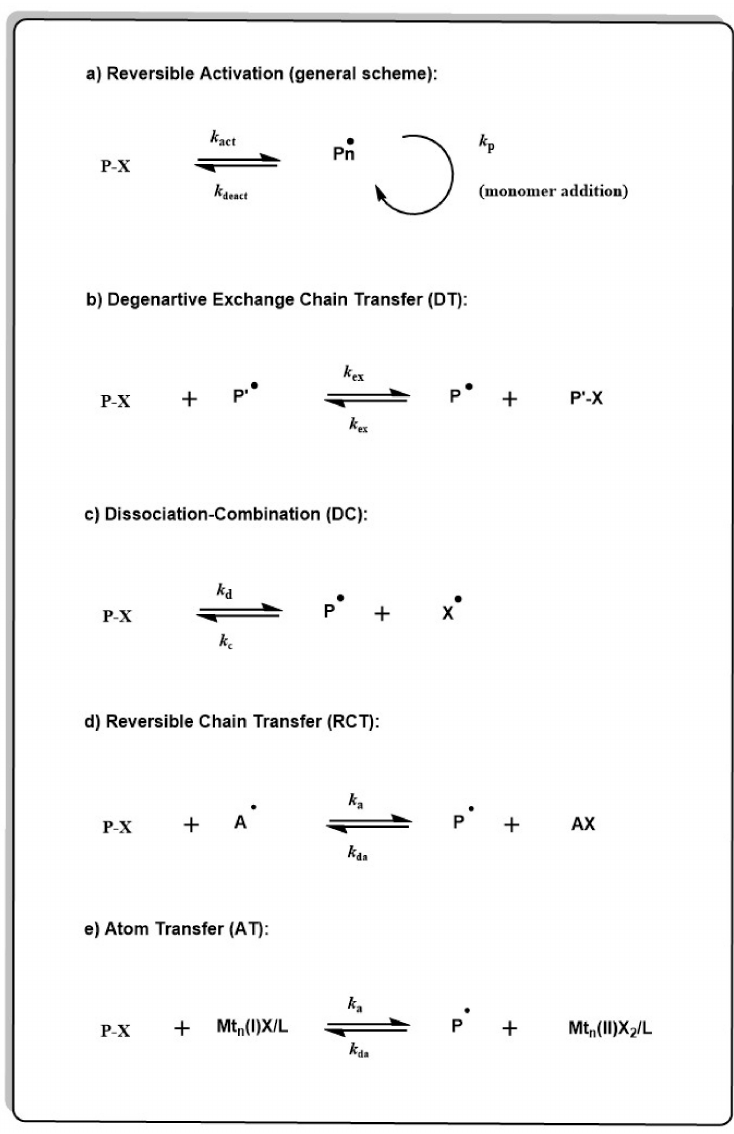
Scheme 1. The most common mechanisms for reversible activation in polymerization